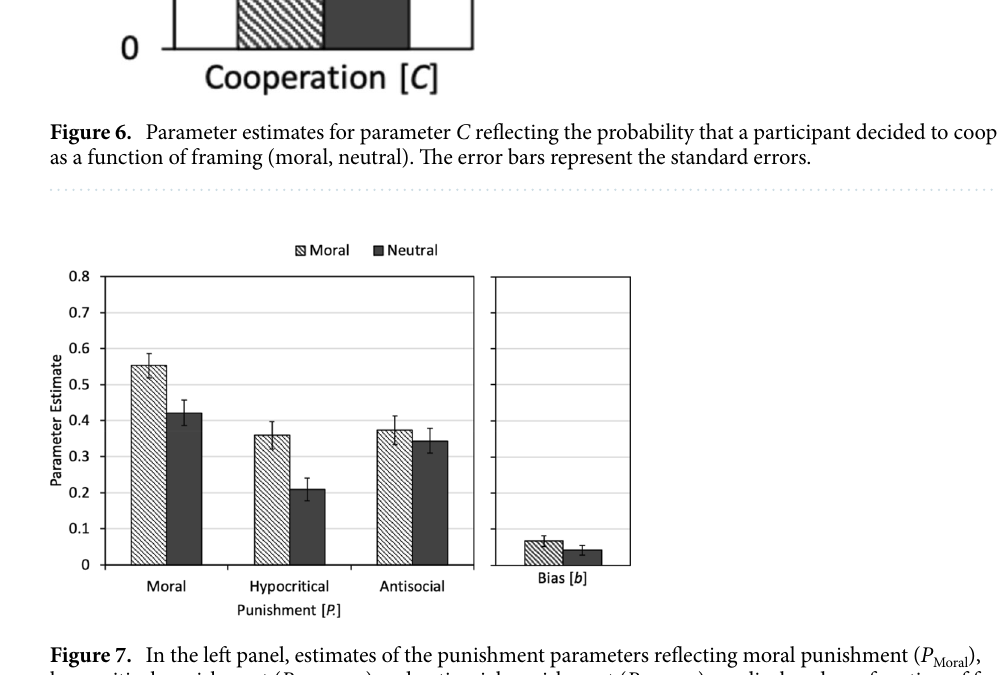
Figure 7. In the left panel, estimates of the punishment parameters reflecting moral punishment ( P Moral ), hypocritical punishment ( P Hypocritical ) and antisocial punishment ( P Antisocial ) are displayed as a function of framing (moral, neutral). In the right panel, the estimate of the punishment bias parameter ( b ) is displayed. The error bars represent the standard